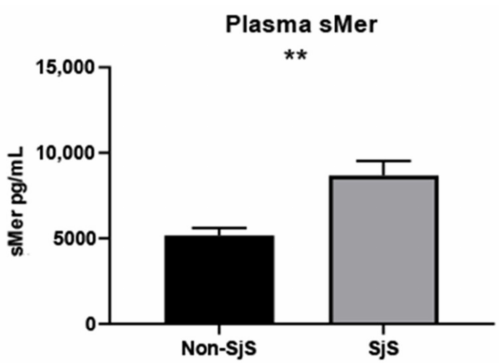
Figure 5. SjS patients present higher sMer levels in sera. Plasma from SjS patients (n = 15) and non-SjS patients (n = 15) was diluted 1:10 and evaluated for sMer using a human Mer ELISA kit (RnD Systems). The statistical significance was calculated by two-tailed unpaired t-tests where error bars indicate SEM, ** p <